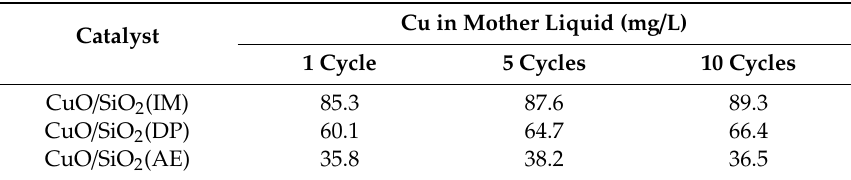
Table 2. Cu leaching of di ff erent